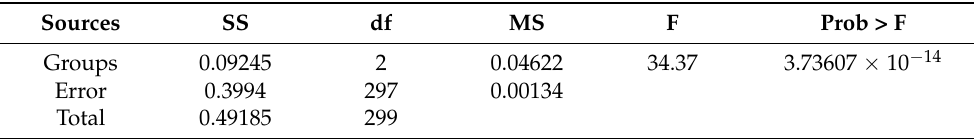
Figure 1. F1 score: test data, all runs. CNN, LSTM, and TPE-LSTM. Table 6. ANOVA